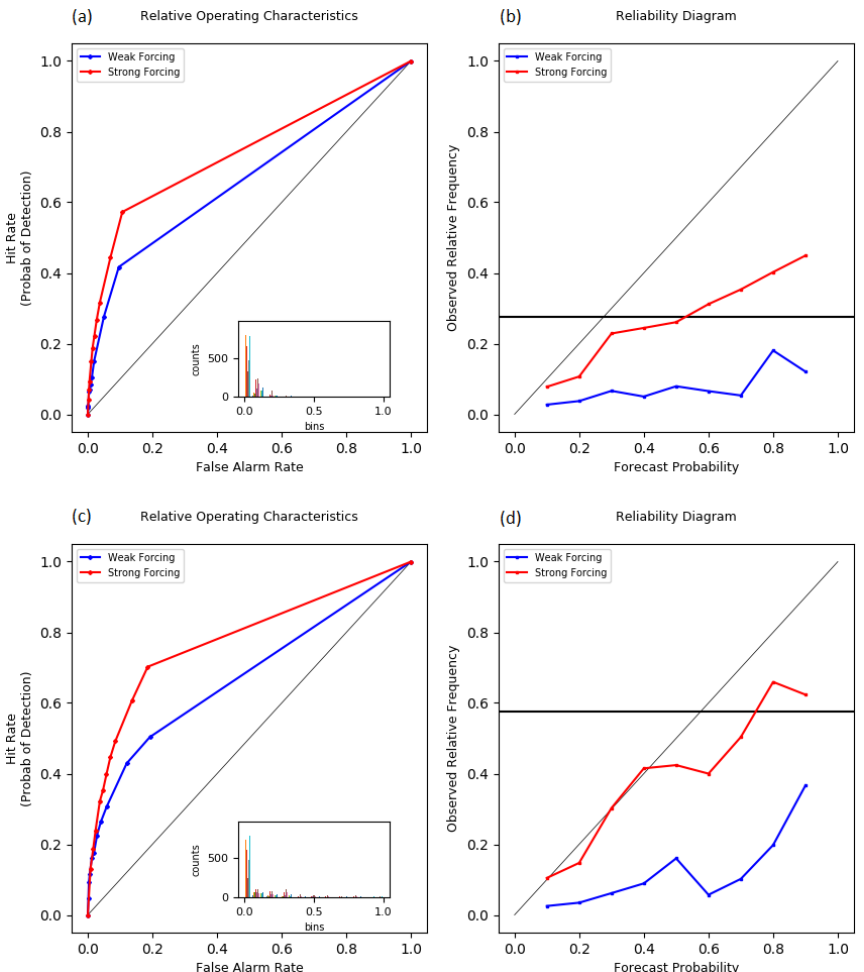
Figure 12. Relative operating characteristics (ROC) (a, c) and reliability diagram (b, d) for 3mm (3h) − 1 precipitation rates (a, b) and daily amounts of 10mm (24h) − 1 (c, d) conditional on weather regime aggregated over the entire